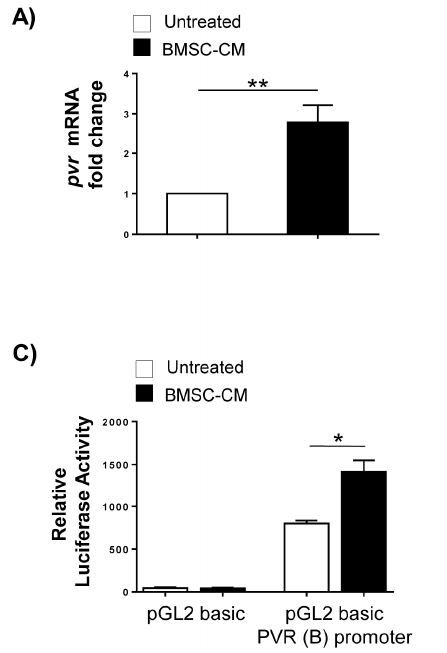
Figure 4. BMSC-CM increases PVR mRNA expression and promoter activity in MM cells. Real Time PCR analysis of total mRNA obtained from SKO-007(J3) cells ( A ) or patient-derived PCs ( B ) after 48 h stimulation with BMSC-CM or complete RPMI1640 medium. Data, expressed as fold change units, were normalized with GAPDH and referred to the untreated cells, considered as calibrator. For SKO-007(J3) cells, histograms represent the mean ± SD from three independent experiments. For primary myeloma cells, data from nine MM patients are shown where each dot represents a single patient. (* p < 0.05; ** p < 0.005; paired Student t -test). ( C ) SKO-007(J3) cells were transiently transfected with pGL2 basic ‐ empty vector/PVR (B) promoter plasmid as described in materials and methods. After 48 h of treatment with BMSC-CM, SKO-007(J3) cells were harvested and protein extracts were prepared for the luciferase assay. Data, expressed as relative luciferase activity, were normalized to protein concentration and renilla activity and represent the mean ± SD from three independent experiments (* p < 0.05; paired Student t ‐ test).